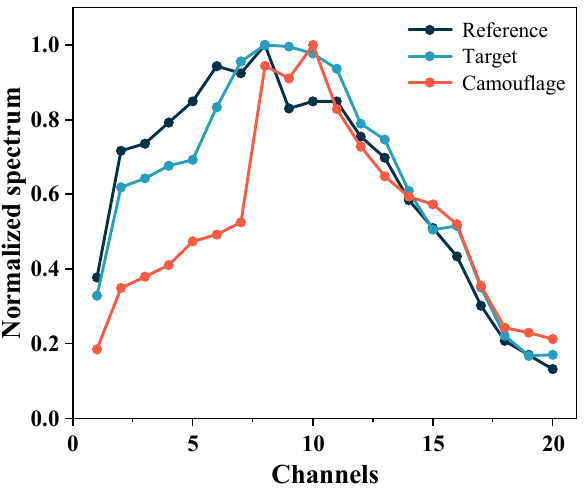
Figure 12. Characteristic spectrogram of channel composition selected by clustering and classification after principal component analysis. Table 8. The changes of correlation coefficient of targets’ spectrum before and after using the proposed method.